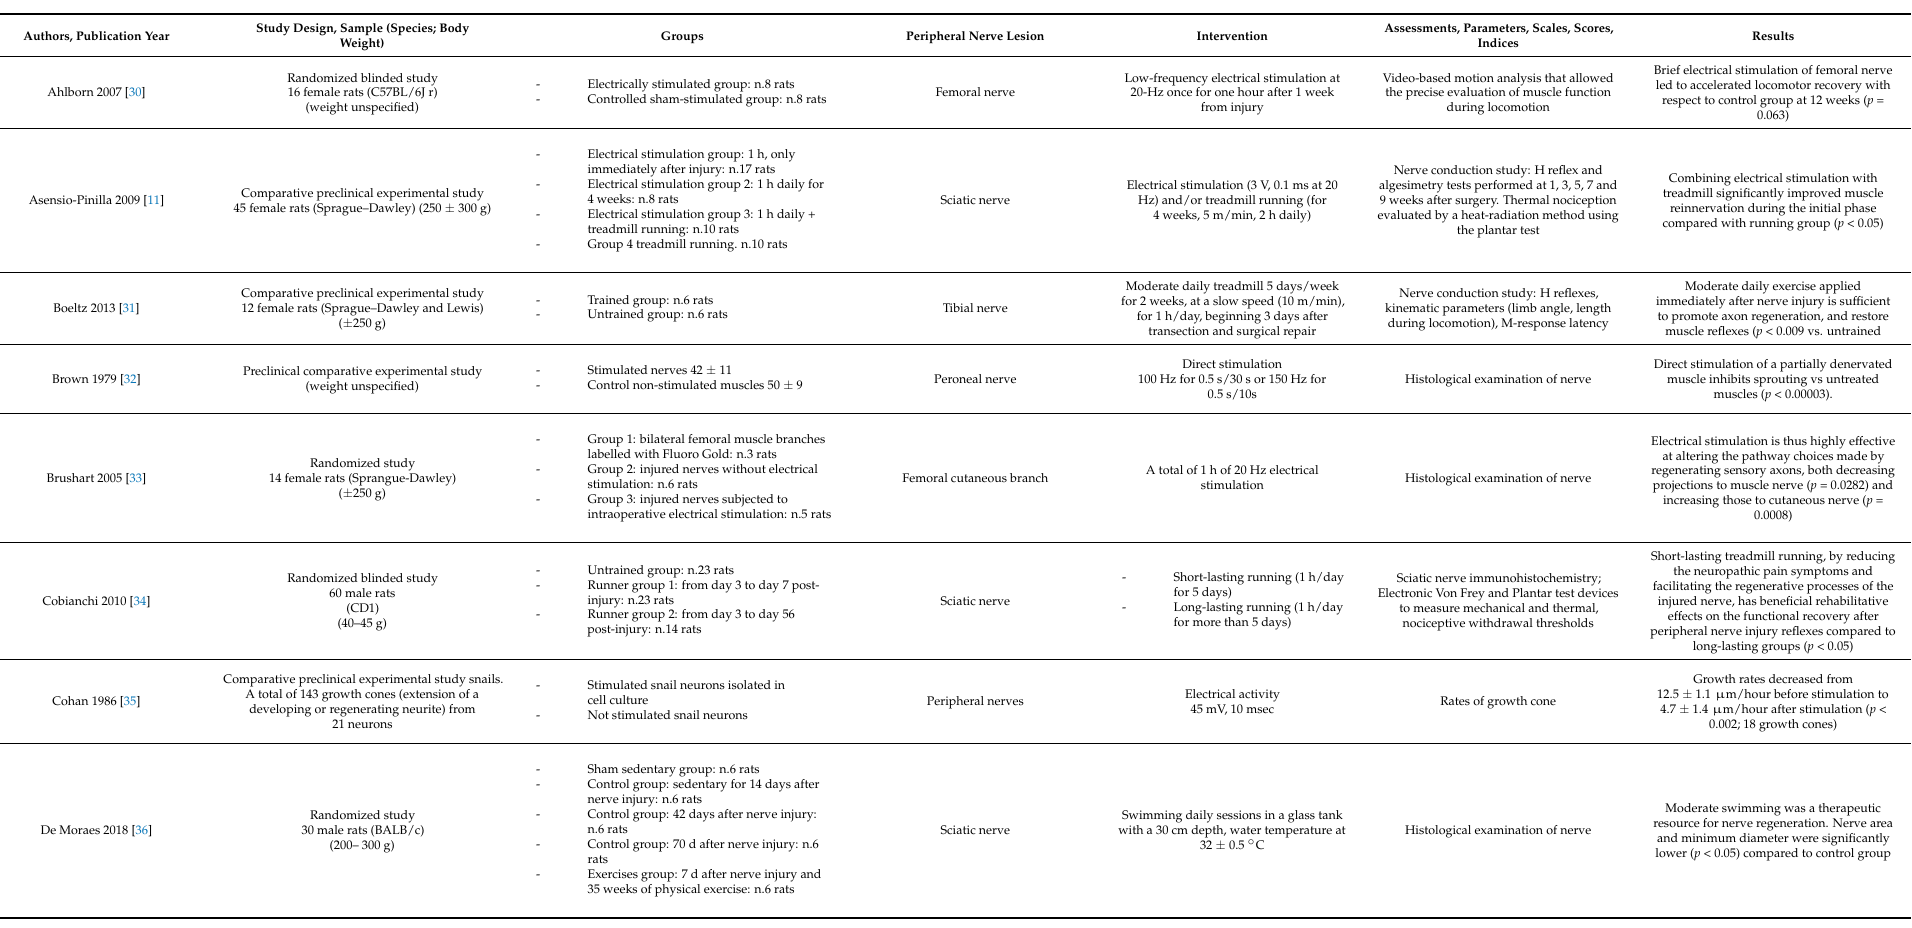
Table 1. Physical exercise and instrumental therapy in peripheral neuropathy in animals: characteristics and outcomes of studies included in the systematic